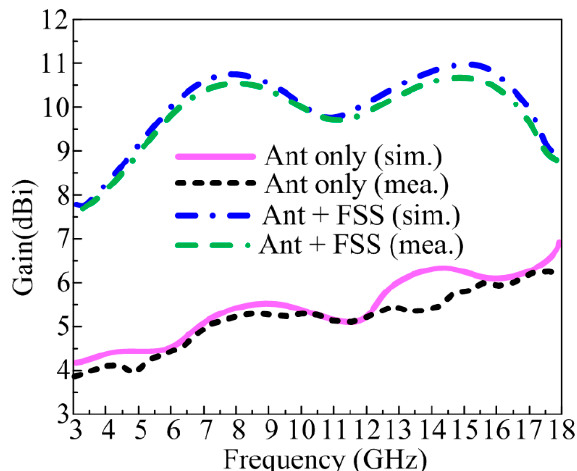
Figure 10. Software-predicted and prototype-measured gain of suggested UWB antenna with and without FSS.